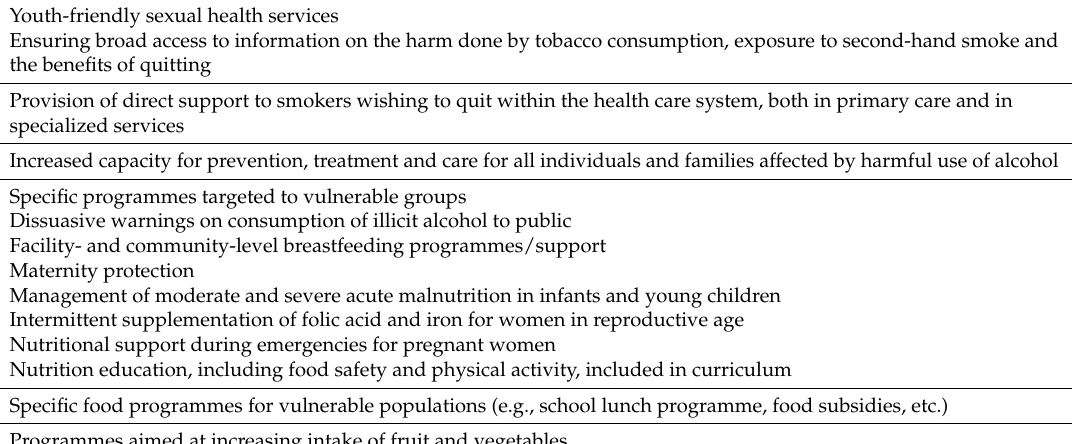
Table 3. Health promotion services to be provided both in primary care or public health settings